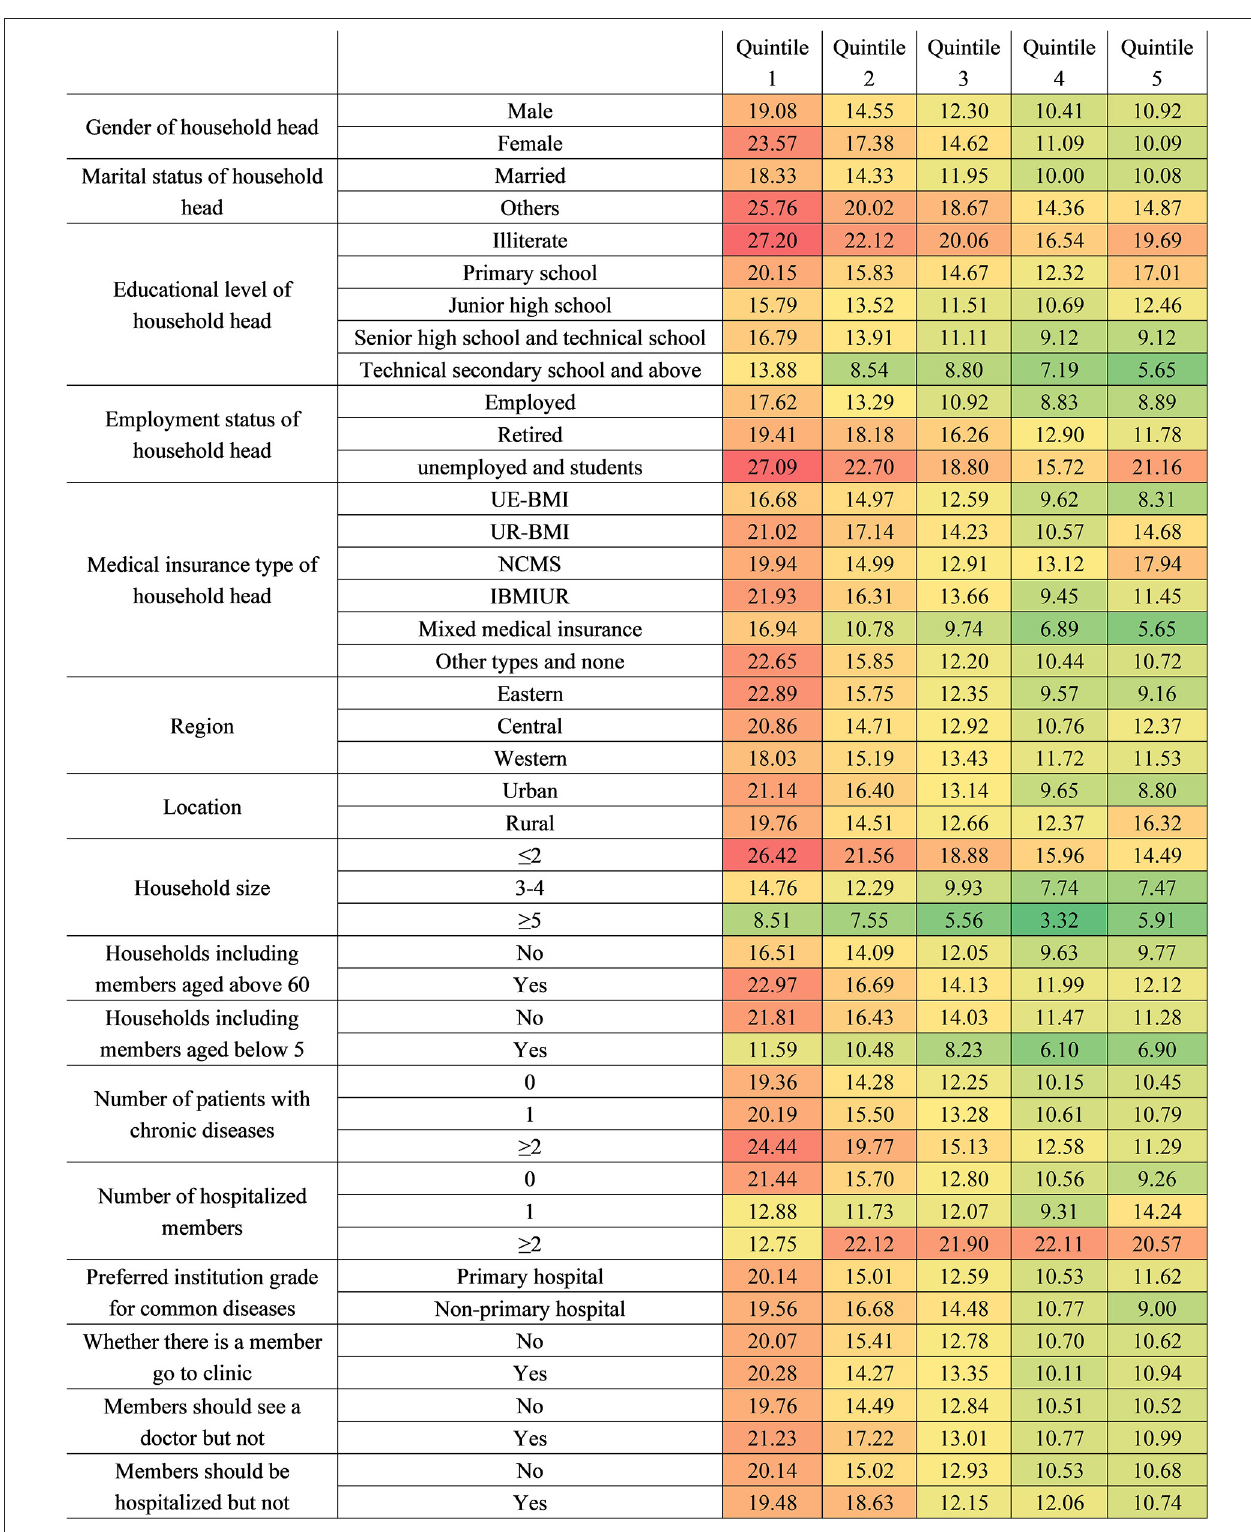
FIGURE 6 | The CHE standardized rate by different economic quintile groups.